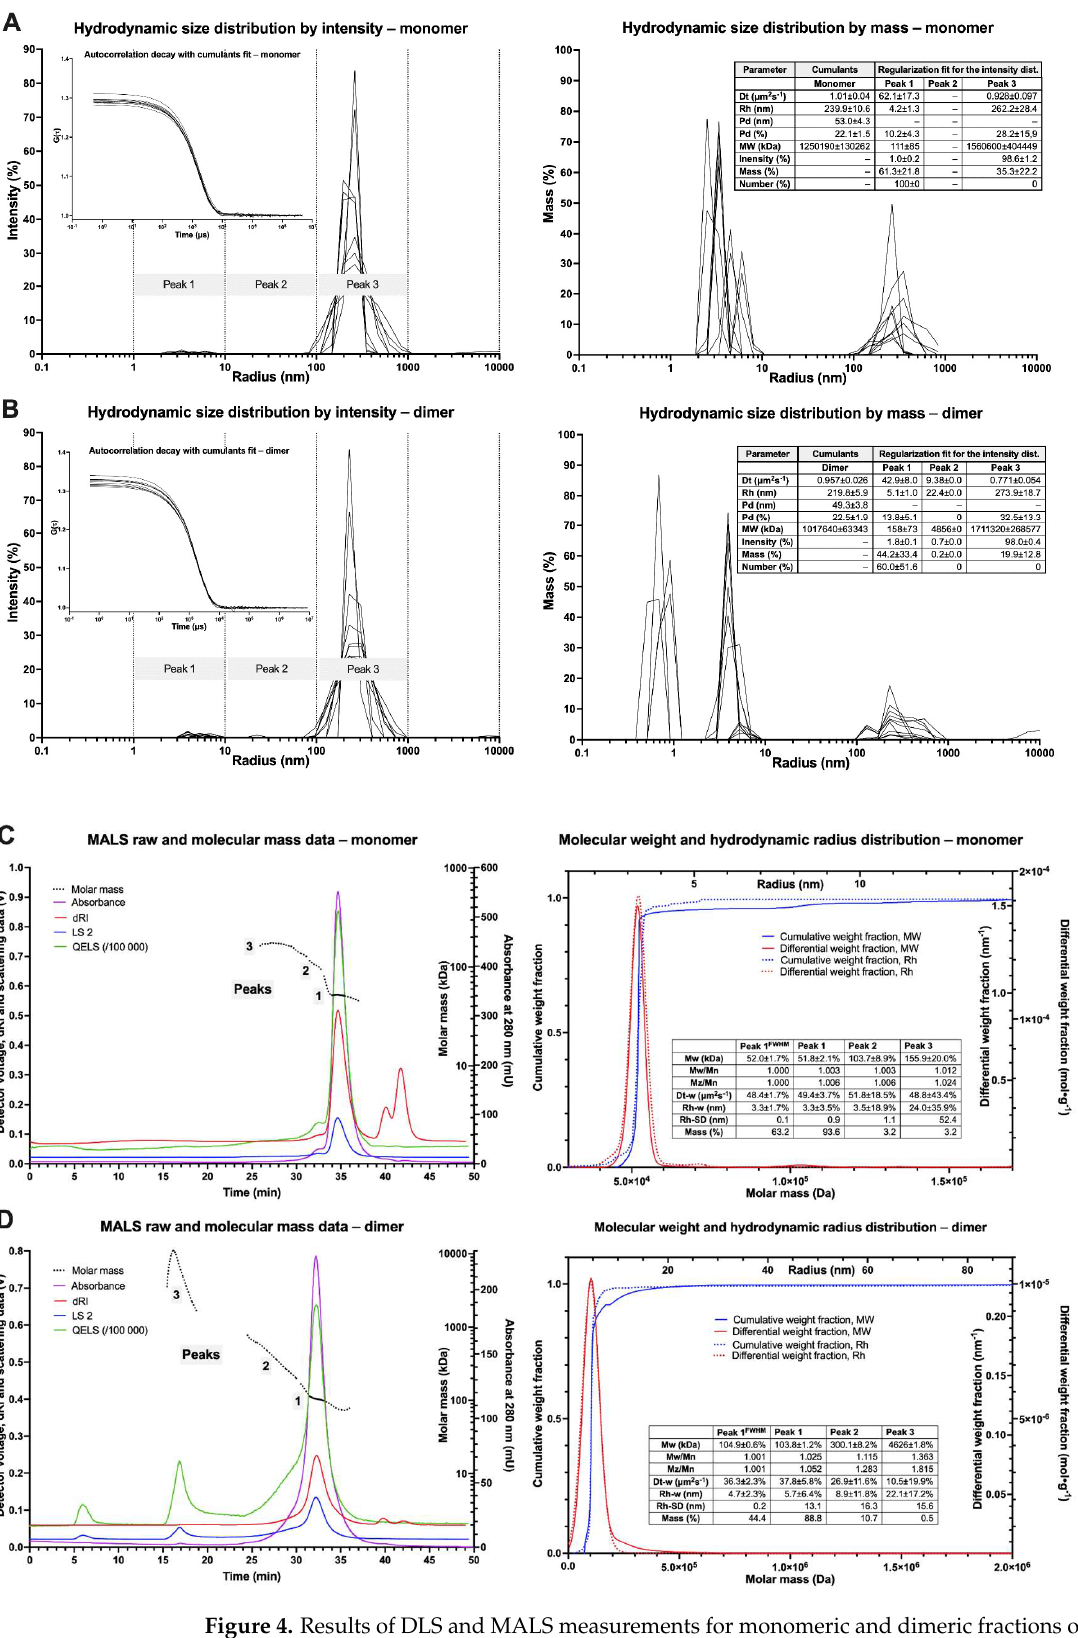
Figure 4. Results of DLS and MALS measurements for monomeric and dimeric fractions of DT390-IL-13. ( A ) DLS of monomeric fractions. ( B ) DLS of dimeric fraction. ( C ) MALS of monomeric fractions. ( D ) MALS of dimeric fraction.